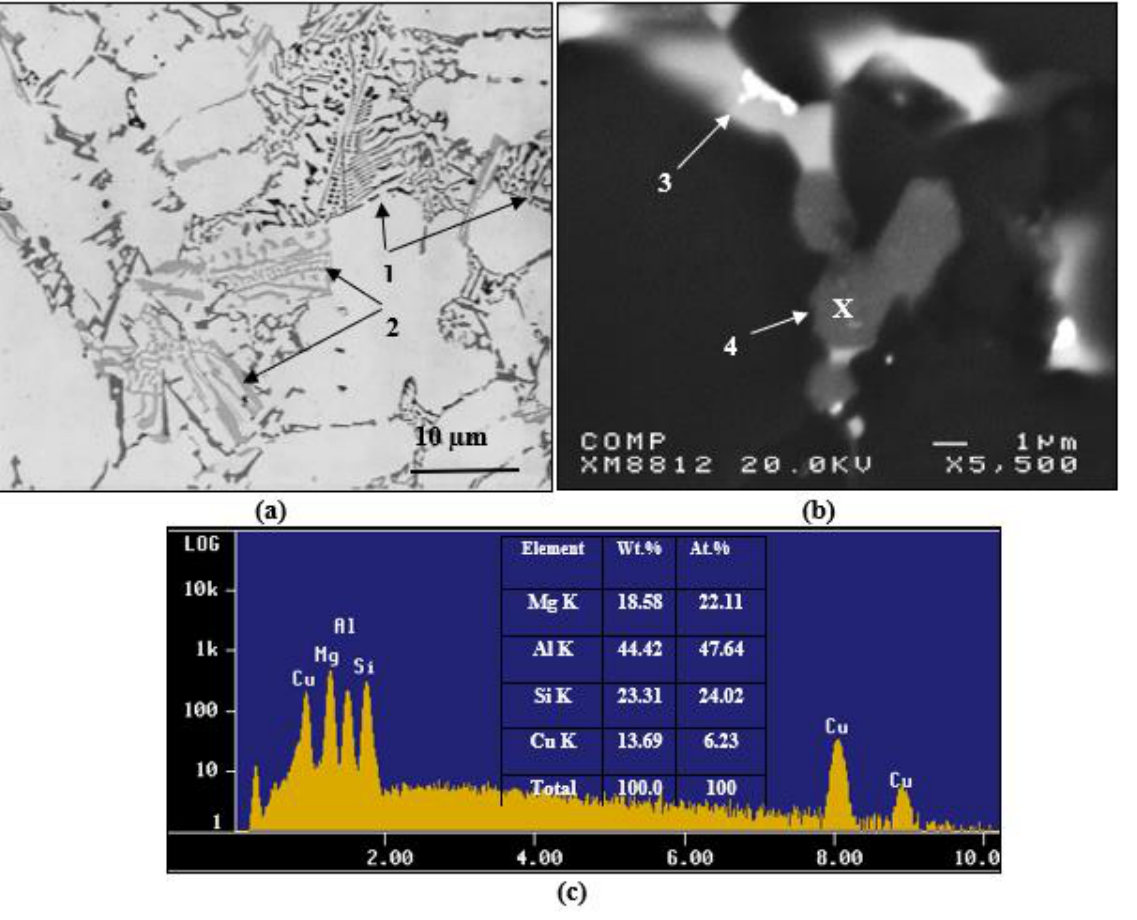
Figure 9. ( a ) Optical microstructure sectioned from alloy C (0.35 °C/s) showing 1 — Mg 2 Si, and 2 — Π -Fe phase particles, ( b ) backscattered electron image showing 3 — Al 2 Cu massive particle, and 4 — Q-phase particles, and ( c ) EDS spectrum corresponding to the area marked X in ( b ).